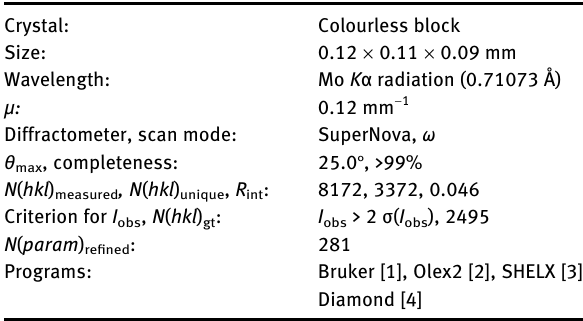
Table  : Data collection and